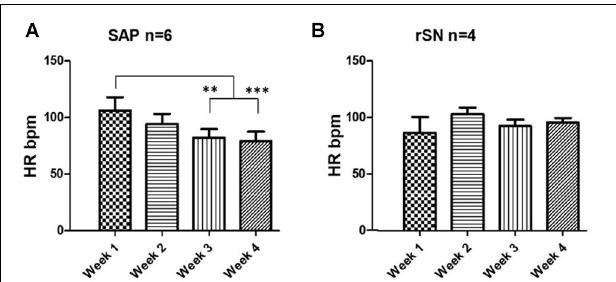
FIGURE 7 | Heart rate change during long-term follow-up. (A) Telemetry heart rate (HR) monitoring indicates a significant HR drop in the third and fourth week of the post-ablation in the goats where emergence of subsidiary atrial pacemaker (SAP) was found (repeated measures ANOVA, ∗∗ P < 0.001 and ∗∗∗ P < 0.0001, respectively). (B) No significant change was observed in the goats with recovery of SAN function